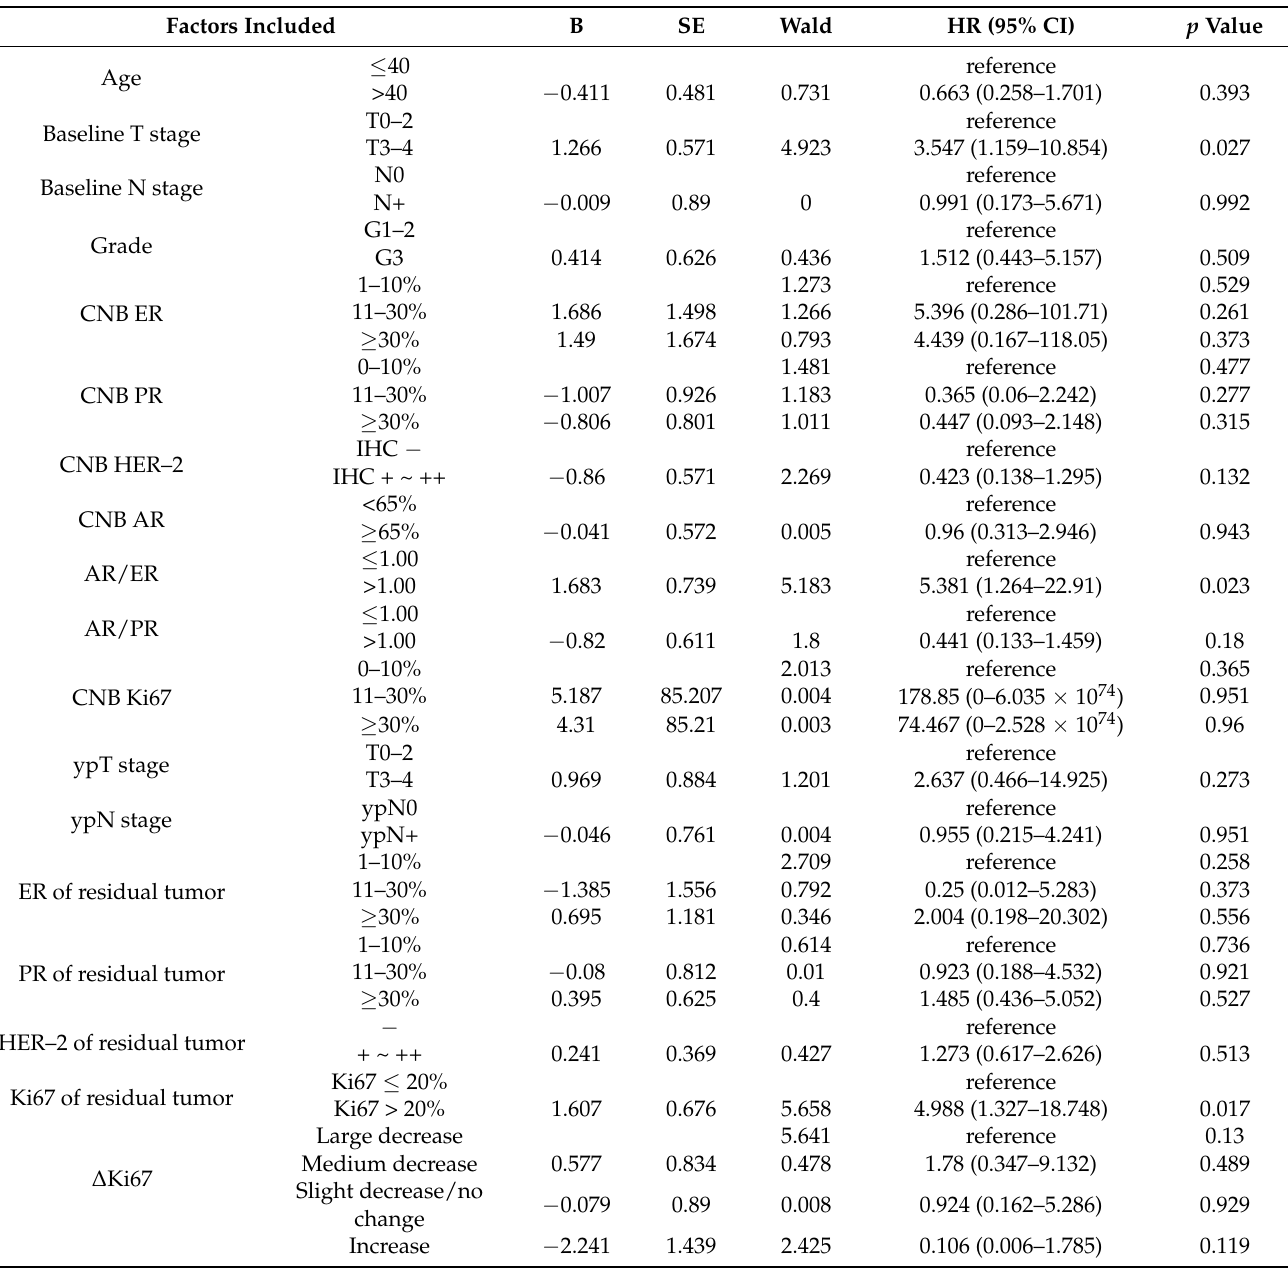
Table 6. Multivariate analysis of DFS in non–pCR Luminal B (HER–2 negative)